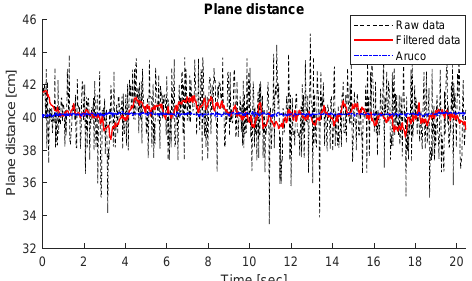
Figure 6: The black plot shows the plane distance ob- tained by the raw data from the lidar mea- surements and the VPD algorithm. The red plot shows the output from the filter shown in Fig. 2, while the blue plot is the distance based on the fiducial markers.